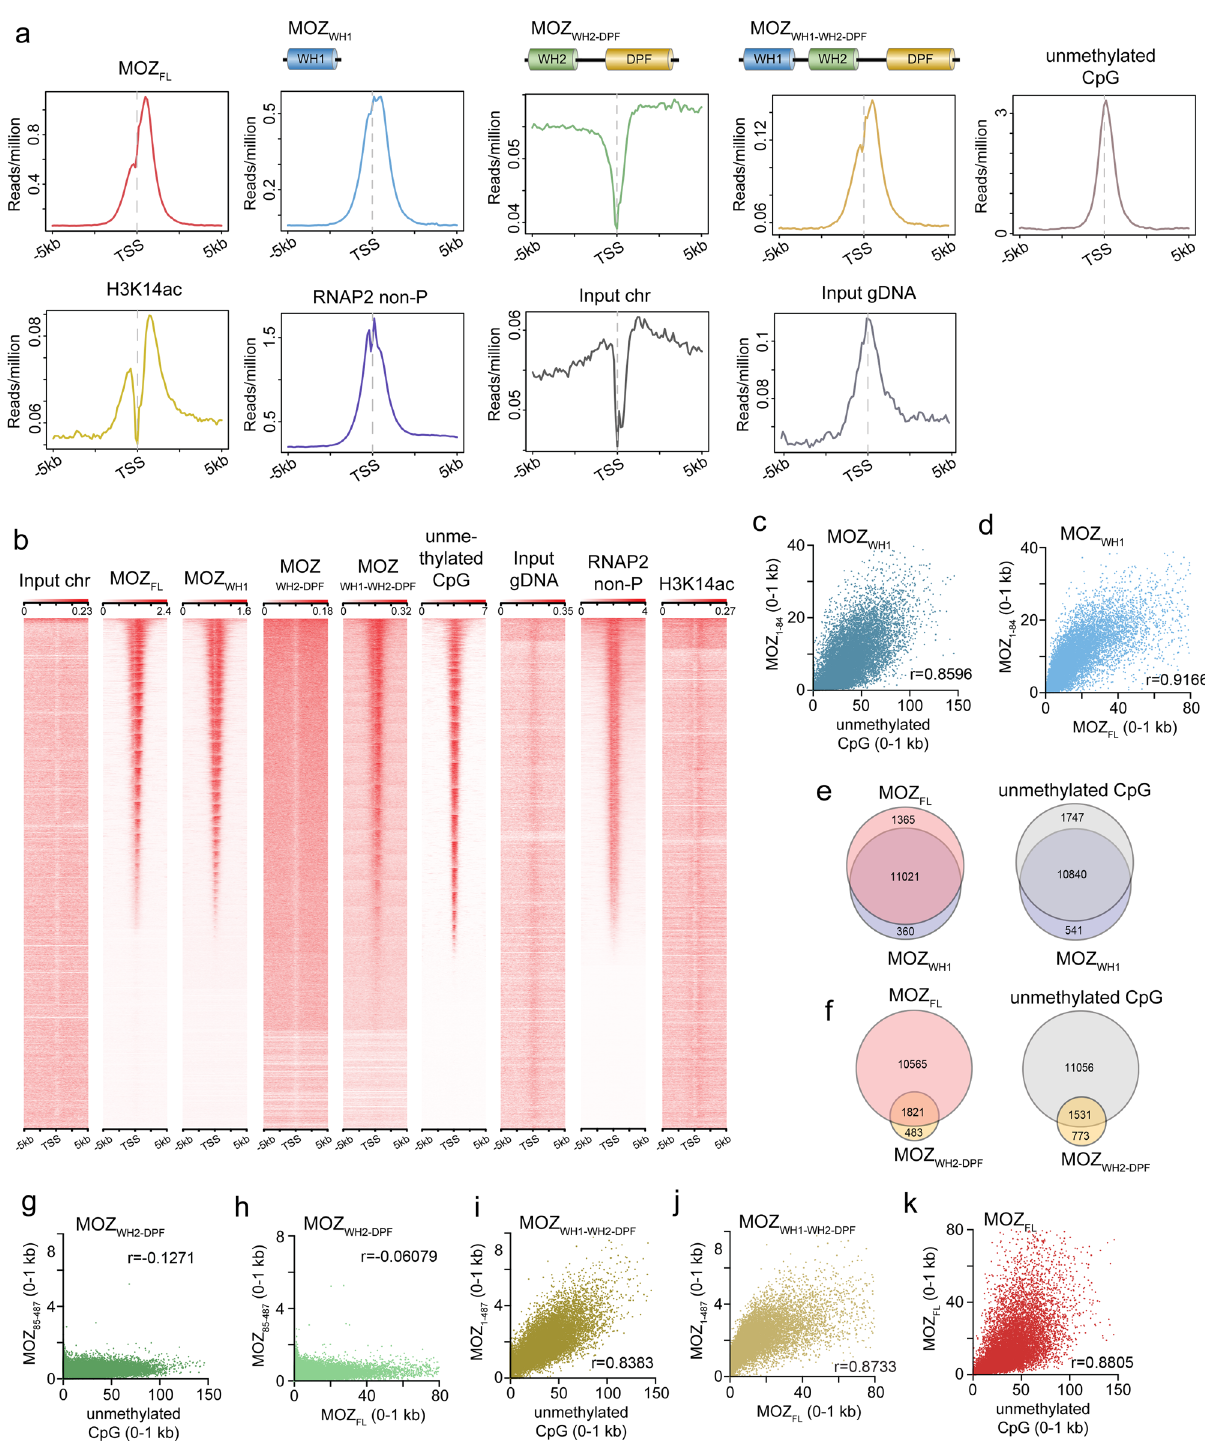
Fig.4|MOZWH1targetsunmethylatedCpGgenomewide.a Averagedistribution of various MOZ proteins near the TSSs. The ChIP signal distribution of endogenous full length MOZ (MOZ FL ), FLAG-tagged MOZ (MOZ WH1 , MOZ WH2 , MOZ WH2-DPF , MOZ WH1-WH2-DPF ), endogenous H3K14ac, and RNA Polymerase II with the non- phosphorylated CTD heptapeptide motif (RNAP2 non-P) within the 5kb range of TSS is shown using ngsplot. The distribution of unmethyated CpGs was determined by CpG island recovery assay coupled with deep sequencing (CIRA-seq). b Heatmaps of ChIP signal intensities of indicated proteins/modi fi cations at TSS are shown using ngsplot. c , d Correlations between the ChIP/CIRA signal intensities of MOZ WH1 and